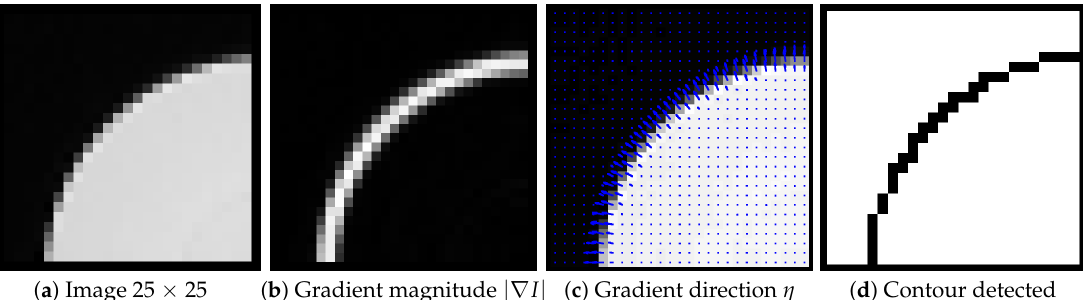
Figure 1. Example of edge detection on an image. In ( c ), arrows representing η are pondered by |∇ I | .